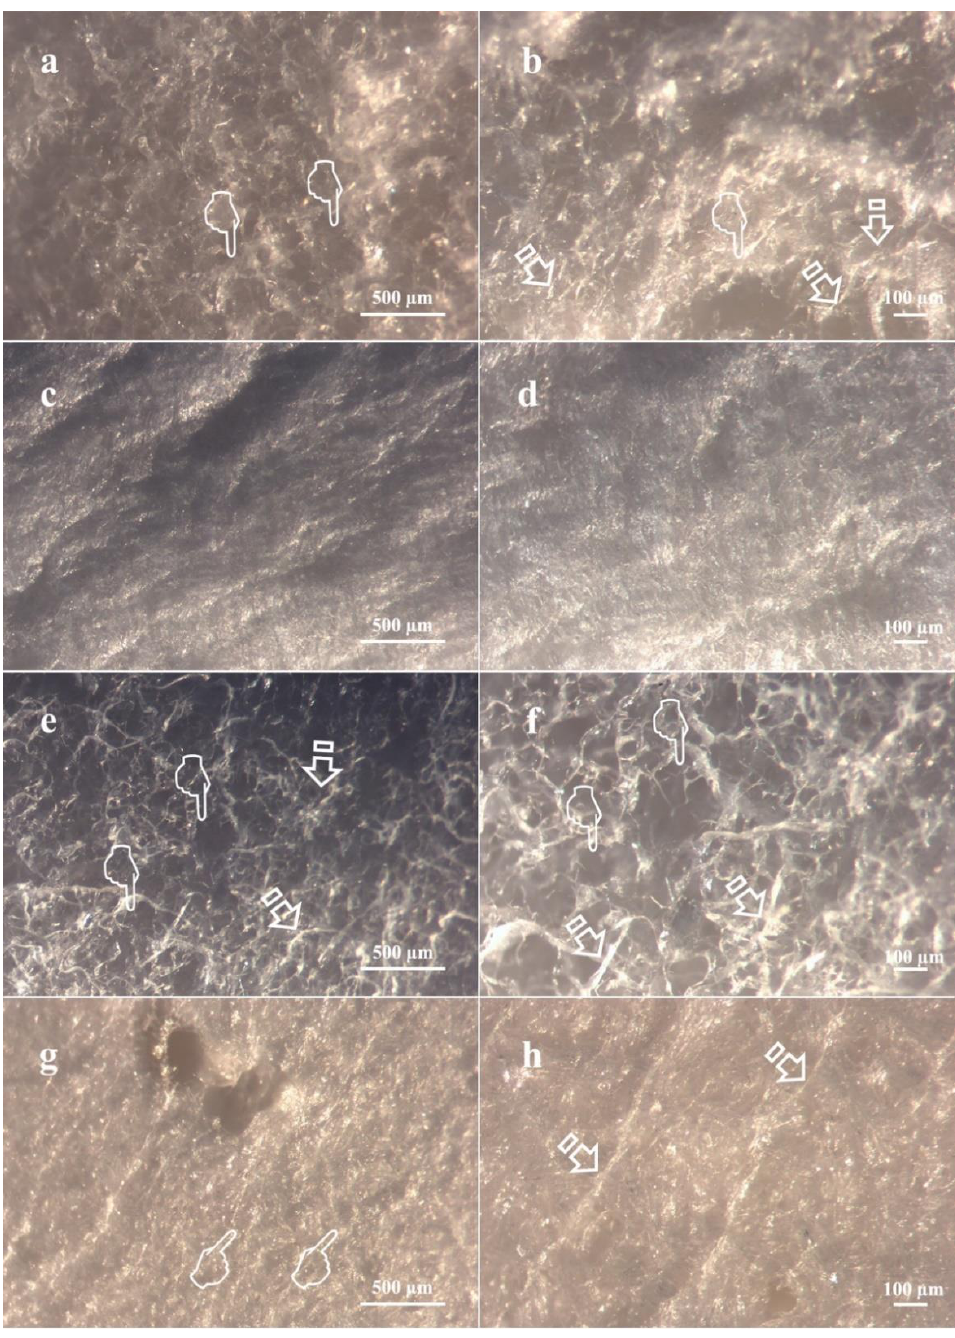
Figure 3. Light micrographs taken from matrices before immersion. ( a ) Fibro-Gide surface at 60× magnification. ( b ) Fibro-Gide at 120× magnification. ( c ) Compact layer Mucograft surface at 60× magnification. ( d ) Compact layer Mucograft surface at 120× magnification. ( e ) Spongious layer Mucograft surface at 60× magnification. ( f ) Spongious layer Mucograft surface at 120× magnification. ( g ) Mucoderm surface at 60× magnification. ( h ) Mucoderm surface at 120× magnification. Scale bar is 500 µm in ( a , c , e , g ), and 100 µm in ( b , d , f , h ). Pointers indicated the presence of different sized pores. Arrows show collagen fibers distributed over matrices’ surfaces.